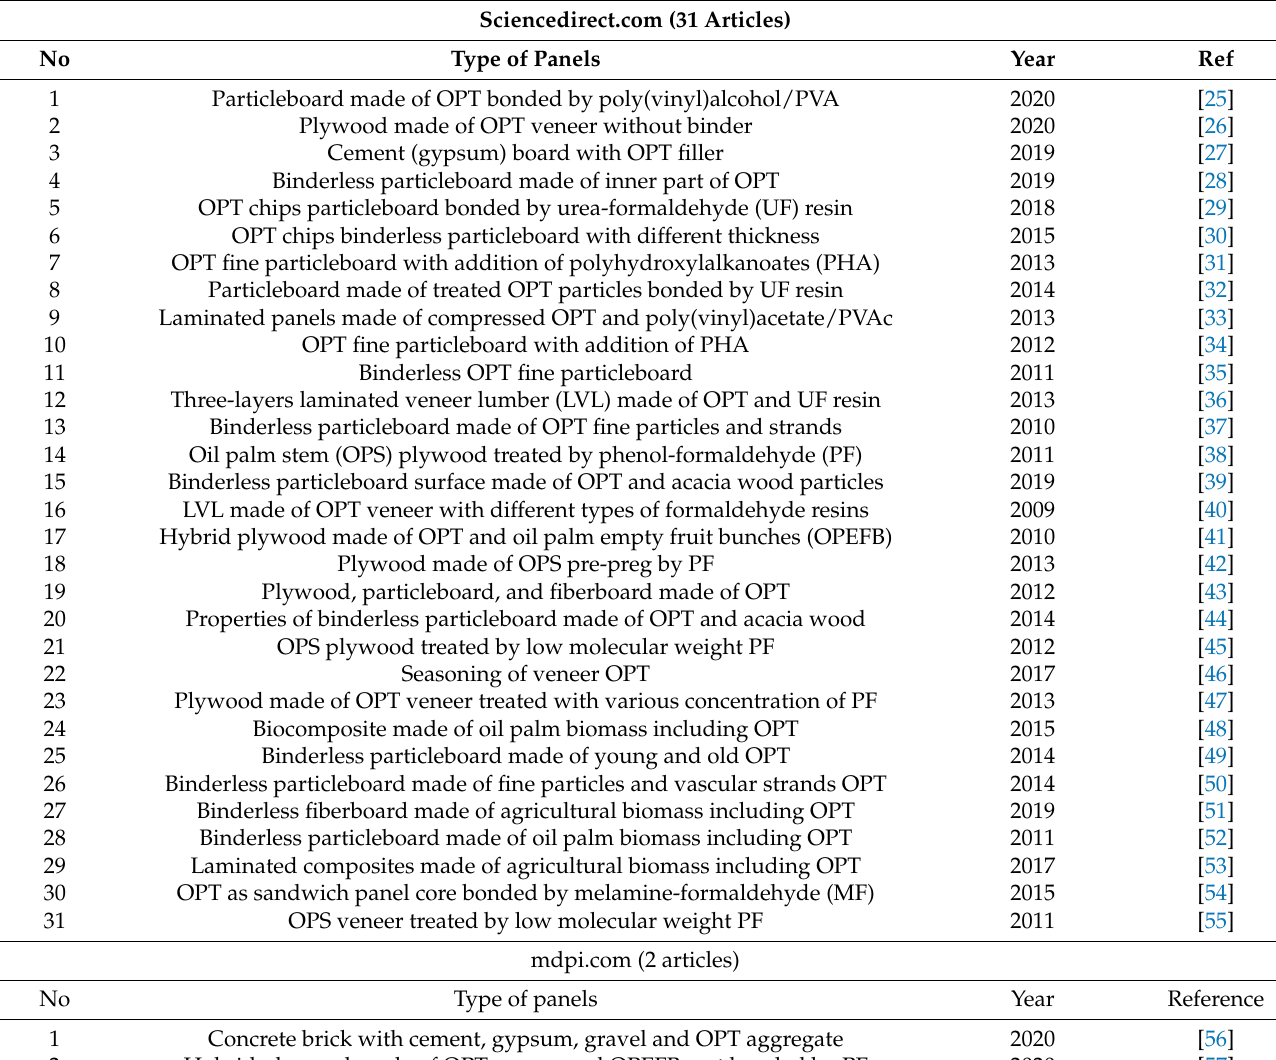
Table 1. Results of the search engine sciencedirect.com uses the keywords: “oil palm trunk” OR “oil palm stem” OR “oil palm